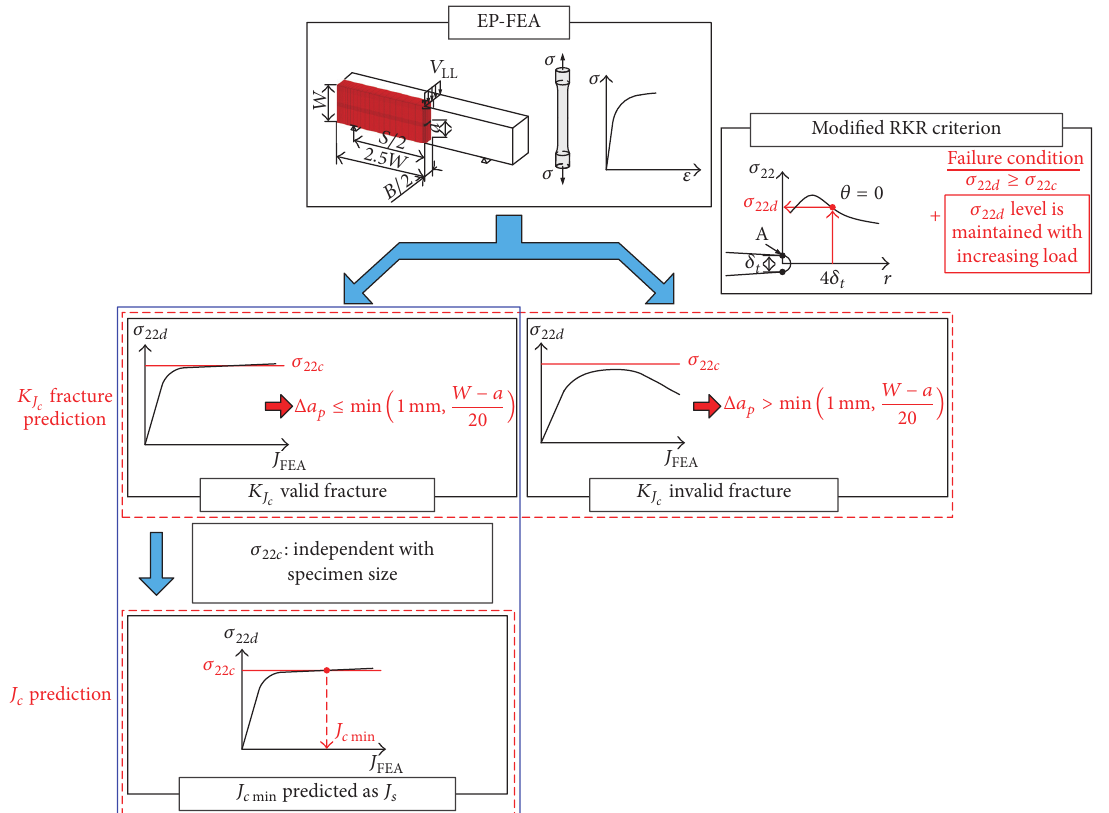
Figure 2: Prediction of 𝐽 𝑐 for the miniature specimens from the experiment using full-size specimens.